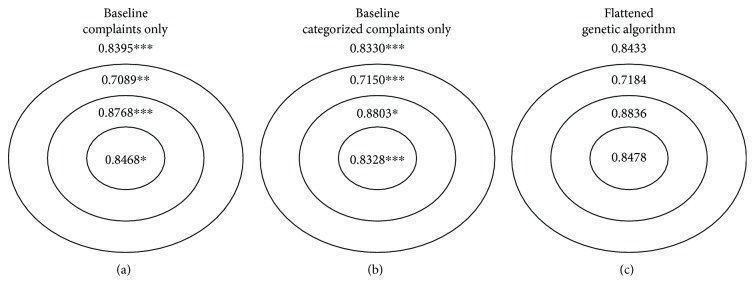
Bullseye performance for baseline models (with specific complaints only and complaint categories only, resp.) and flattened genetic algorithm for the academic hospital. Overall performance is indicated outside of the bullseye. Statistical significance for the difference in 5-fold cross-validated AUC (using DeLong's method) between the flattened genetic algorithm approach and the corresponding baseline models is indicated by ∗∗∗ for p < 0.001, ∗∗ for p < 0.01, and ∗ for p < 0.05.